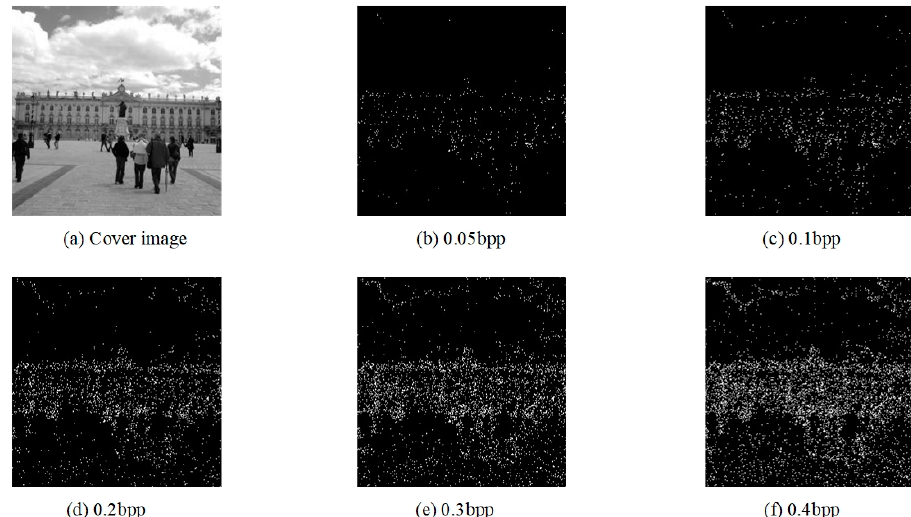
Figure 4. ( a ) One of the cover images in the BOSSbase dataset. ( b – f ) The secret images are obtained by passing the image of ( a ) through the S-UNIWARD steganographic algorithm. The embedding rates of image steganography are 0.05 bpp, 0.1 bpp, 0.2 bpp, 0.3 bpp, and 0.4 bpp respectively.